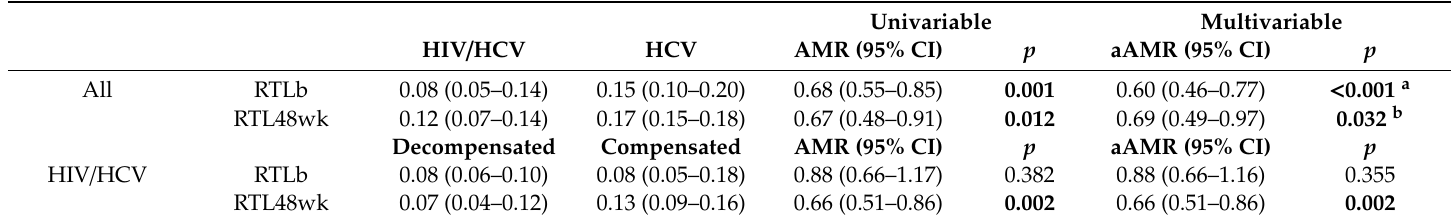
Table 2. Di ff erences in relative telomeres length of patients, stratified based on HIV coinfection and decompensation. Univariable